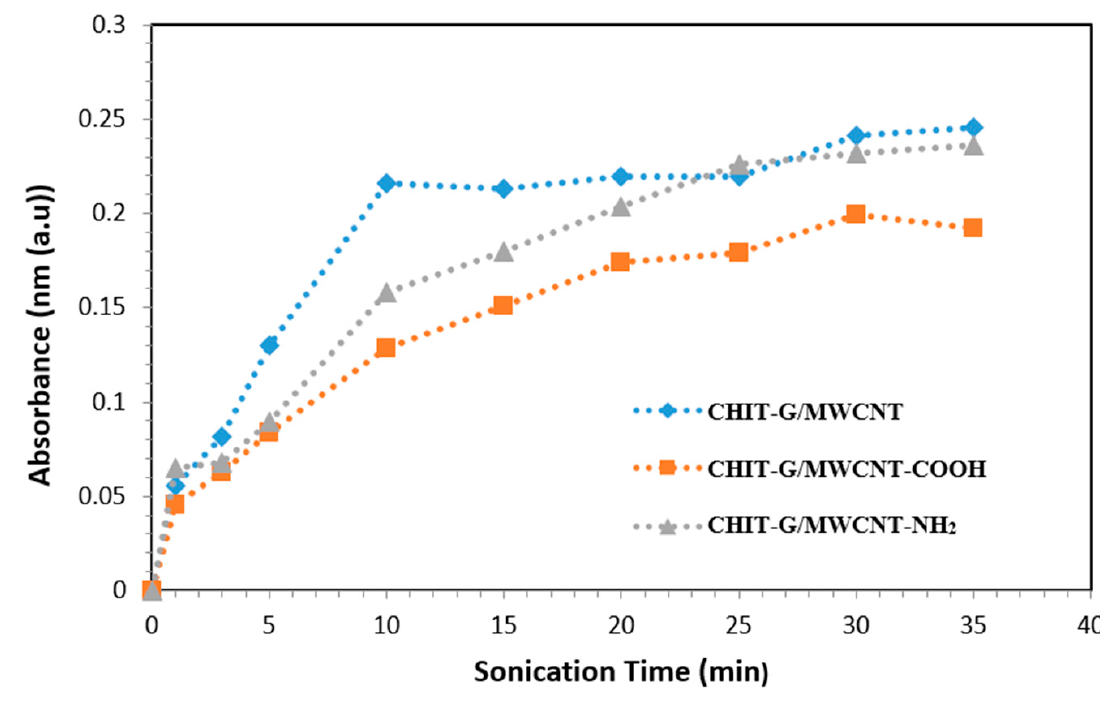
Figure 1. Effects of longer sonication times on the absorbance of MWCNT dispersions at 660 nm.